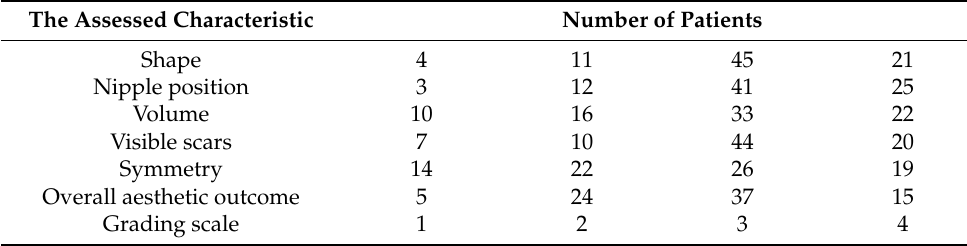
Table A3. The assessment of the outcomes of the operation completed by the doctors just before radiotherapy.